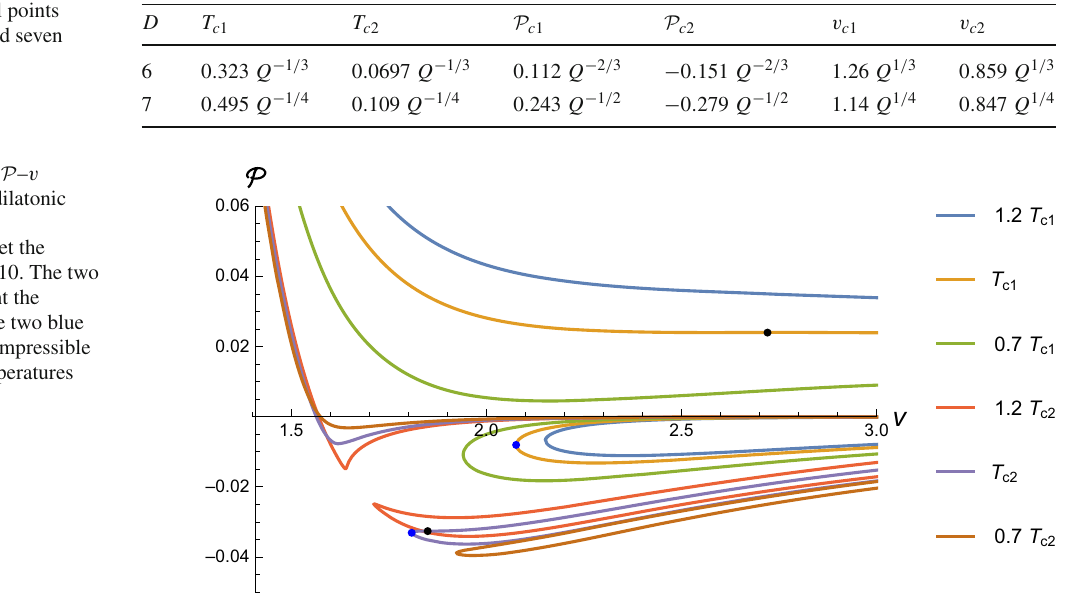
Fig. 1 P – v diagram (left) and T – v diagram (right) of charged dila- tonic AdS black hole with N = 2 , D = 5. We set the electric charge Q = 10.Inthe P – v diagram,thelinesrepresentisothermswithtemper-